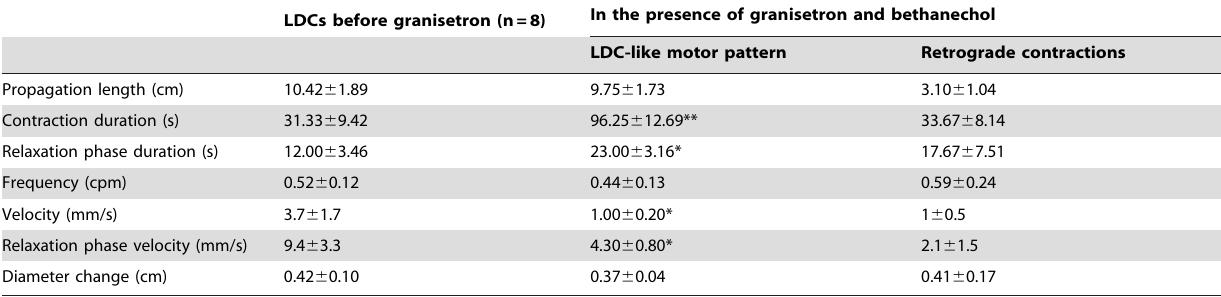
LDCs before granisetron